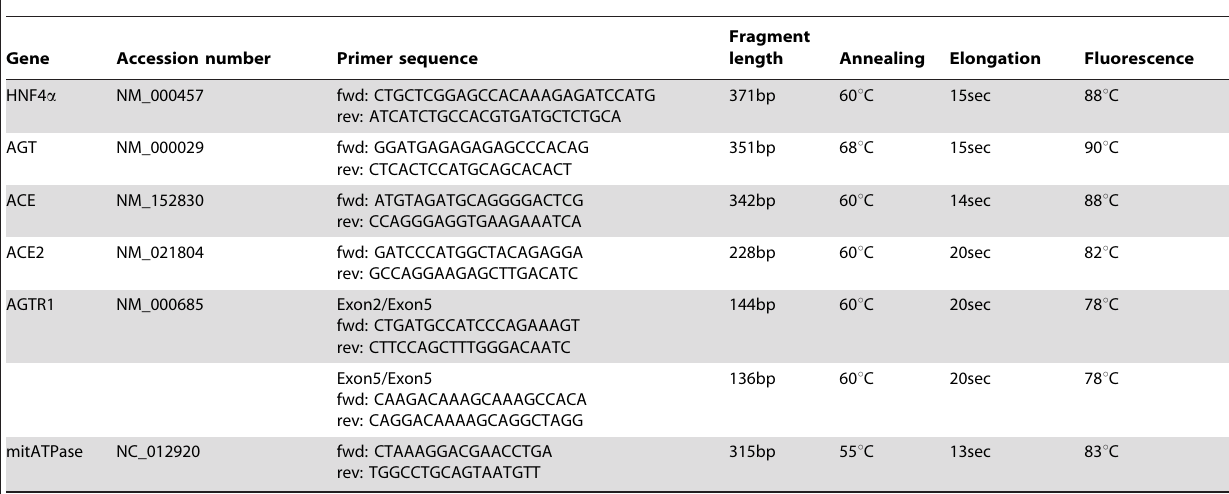
Table 2. Real-Time PCR primer sequences and amplification